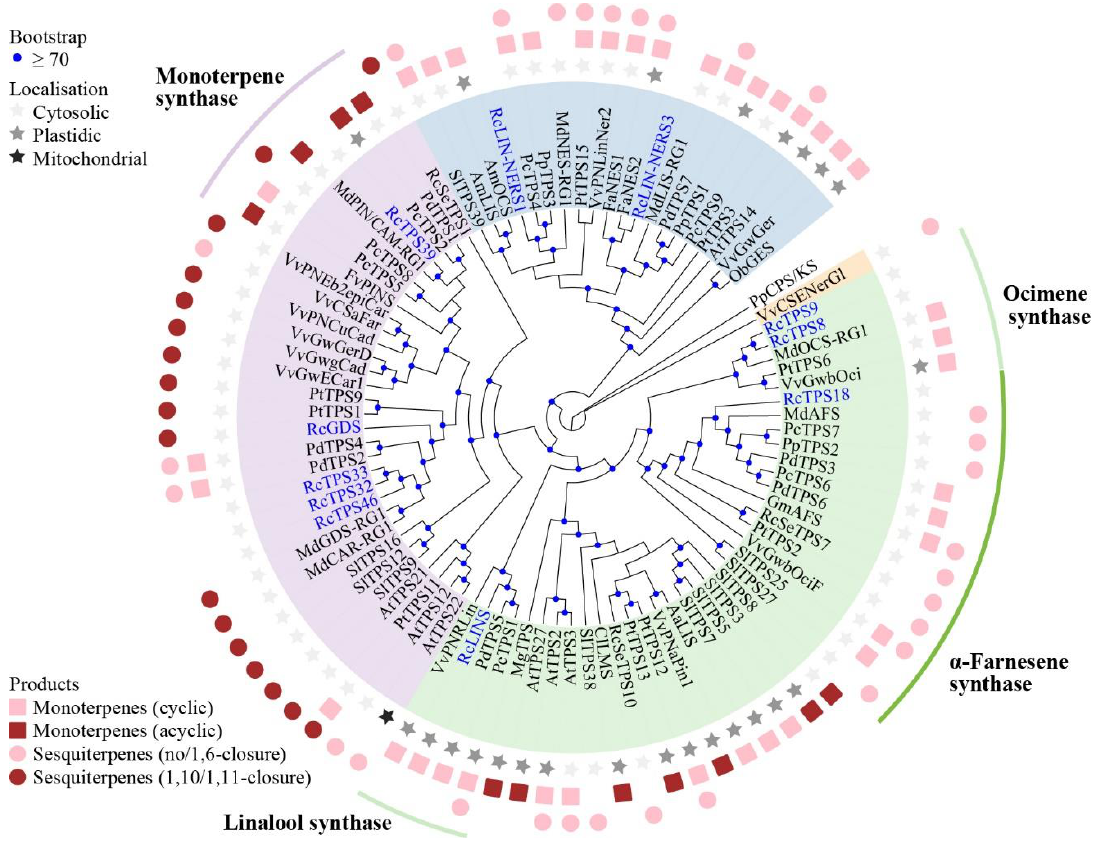
Figure 7. Maximum likelihood phylogeny of petal-expressed RcTPSs and other characterized terpene synthases. RcTPSs are highlighted in blue. The sequences used in this analysis are listed in Table S5. The subfamilies are illustrated with different colors: TPS-a (purple), TPS-b (green), TPS-e/f (orange), and TPS-g (blue).